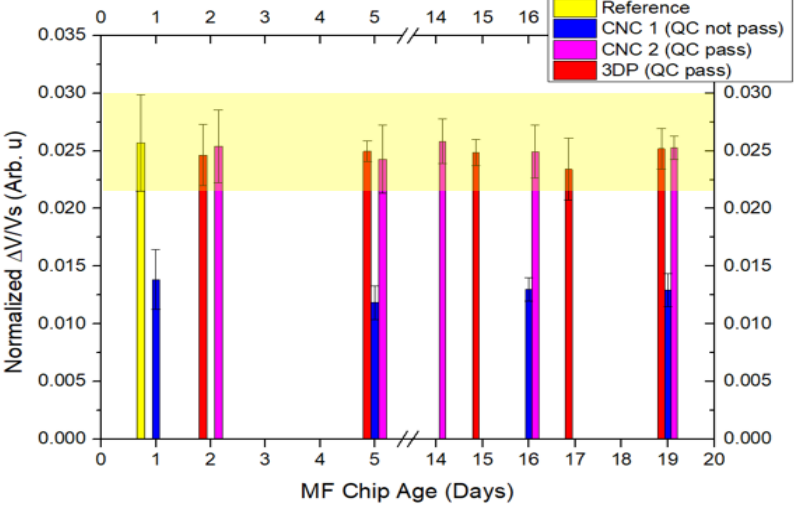
Figure 4. Reproducibility of the molds fabricated by the micro-milling computer numerical control (CNC) and k3D printer (3DP), and the respective repeatability of the measurements up to 19 days. The reference signal (yellow color) was referred from our previous work [29], and used here for comparison—a MF chip was obtained from a mold fabricated using CNC, and used for labeling c-Fn (10 µg/mL) in buffer.